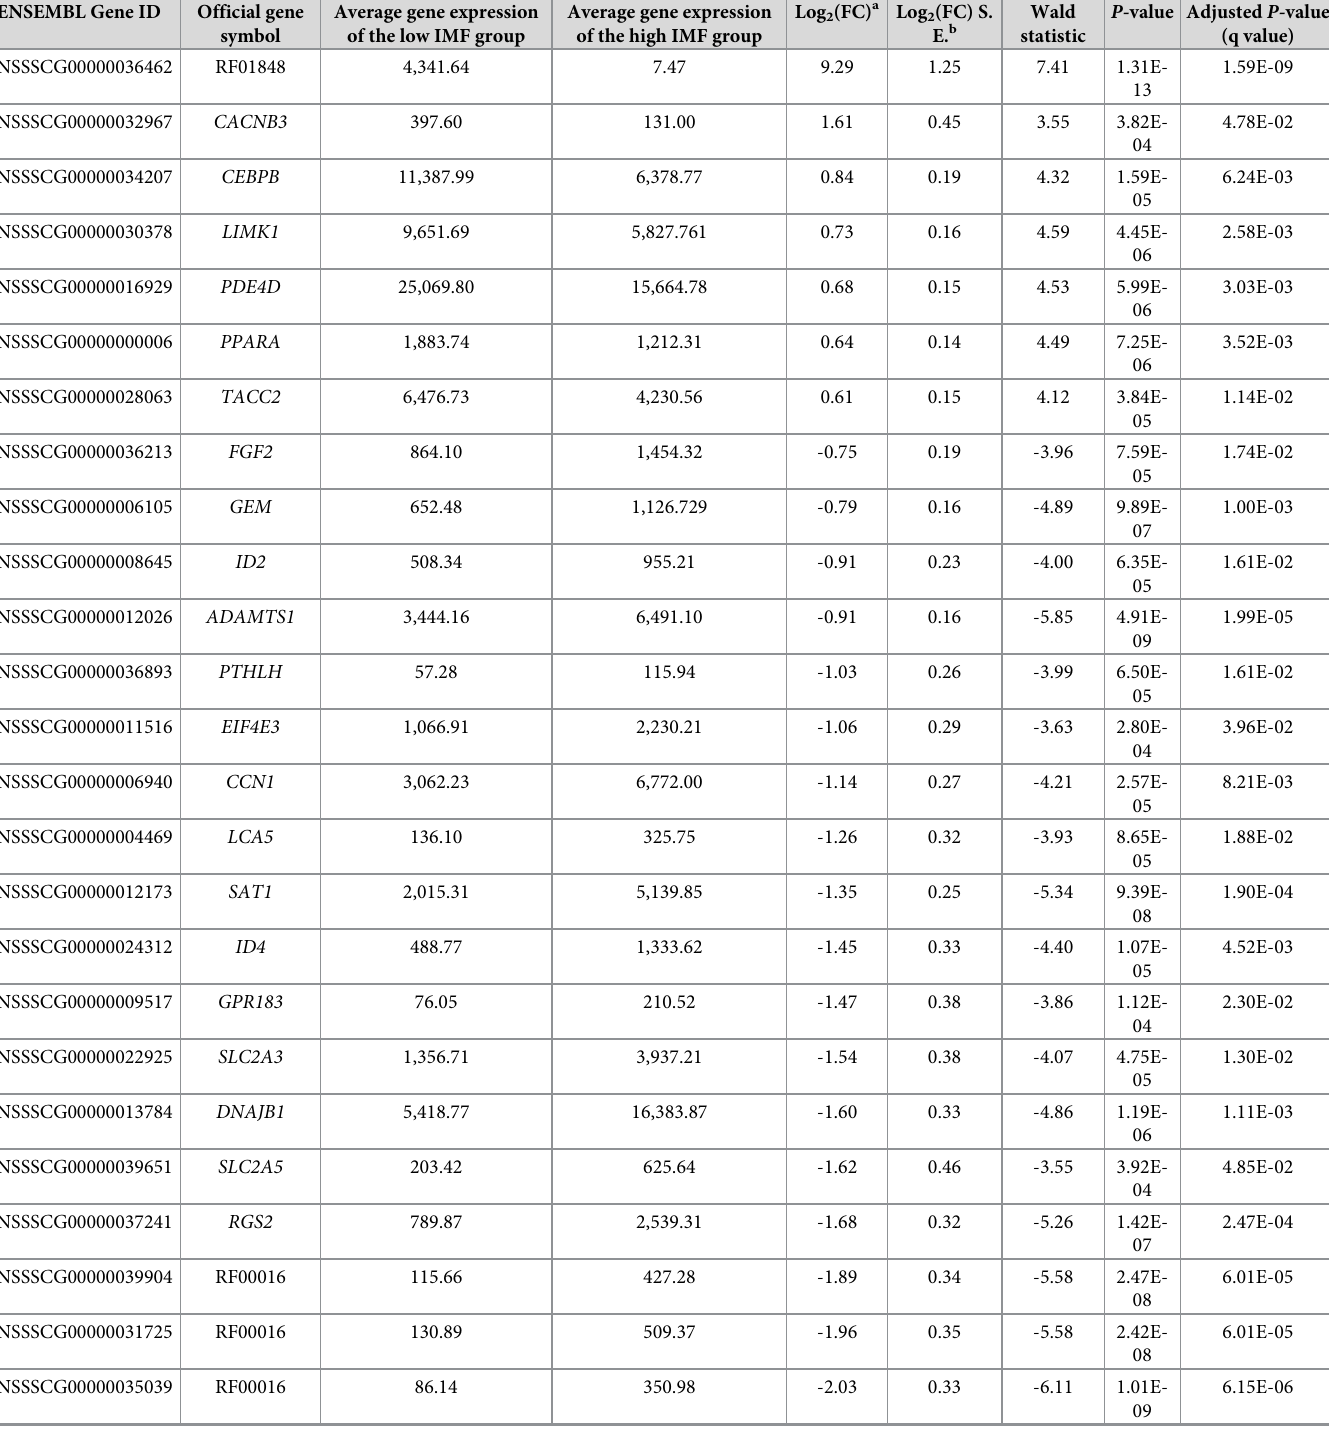
Table 2. List of the main differentially expressed genes (DEGs) associated with Intramuscular Fat (IMF) deposition in porcine Semimembranosus muscle. ENSEMBL Gene